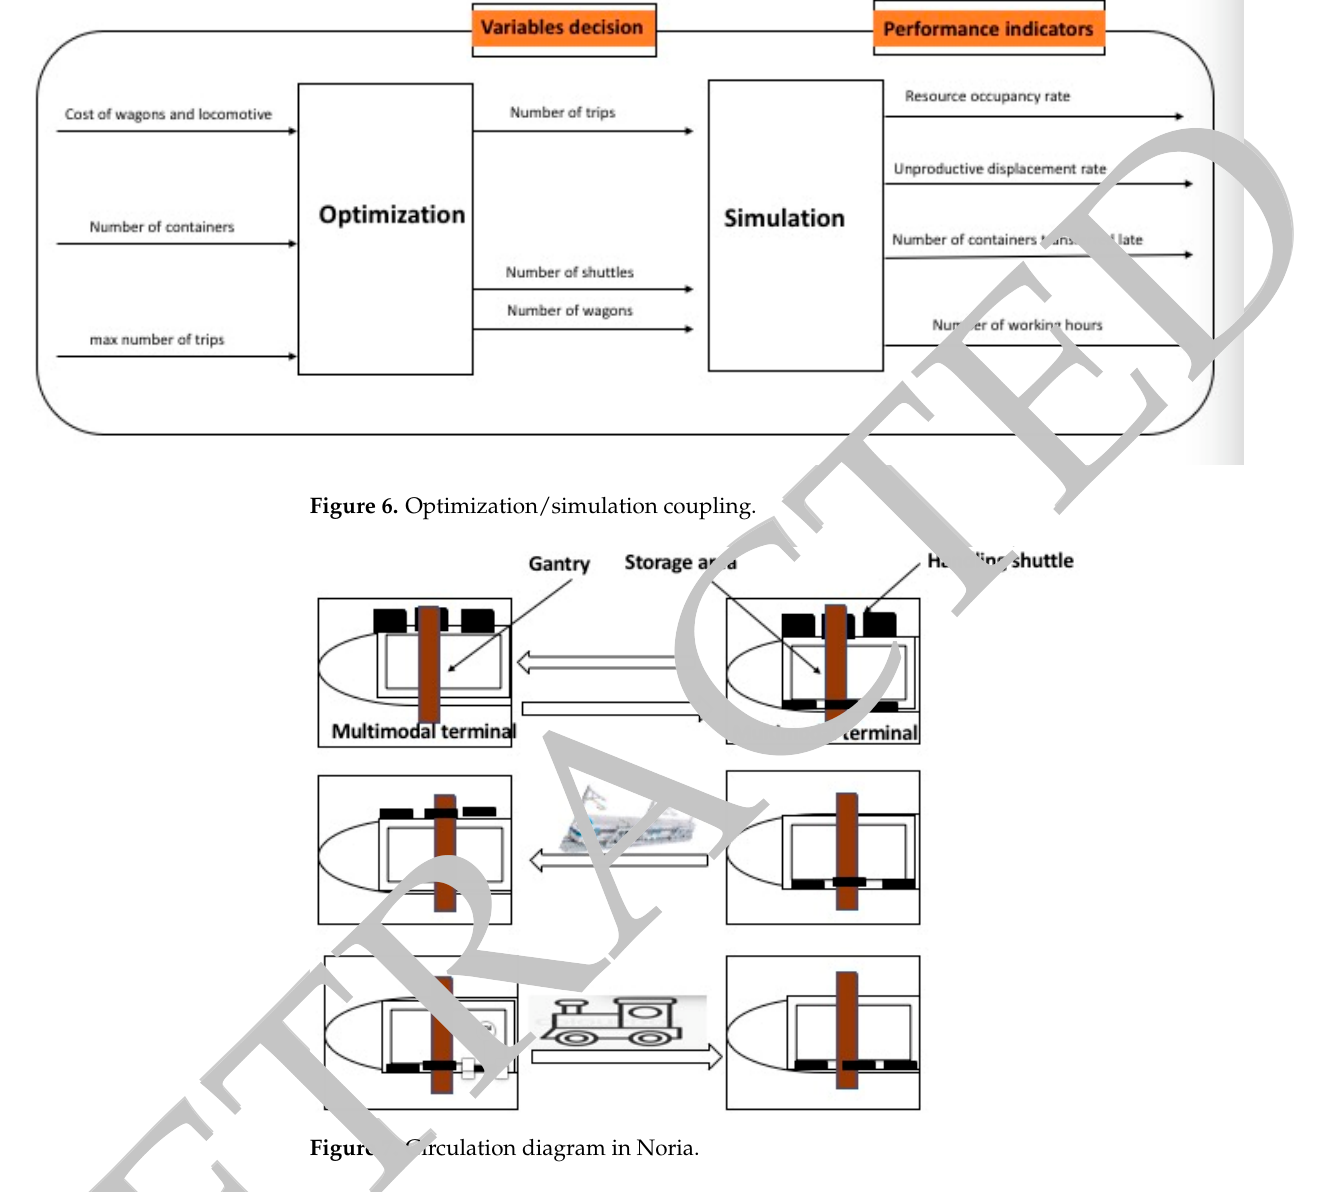
Figure 7. Circulation diagram in Noria.